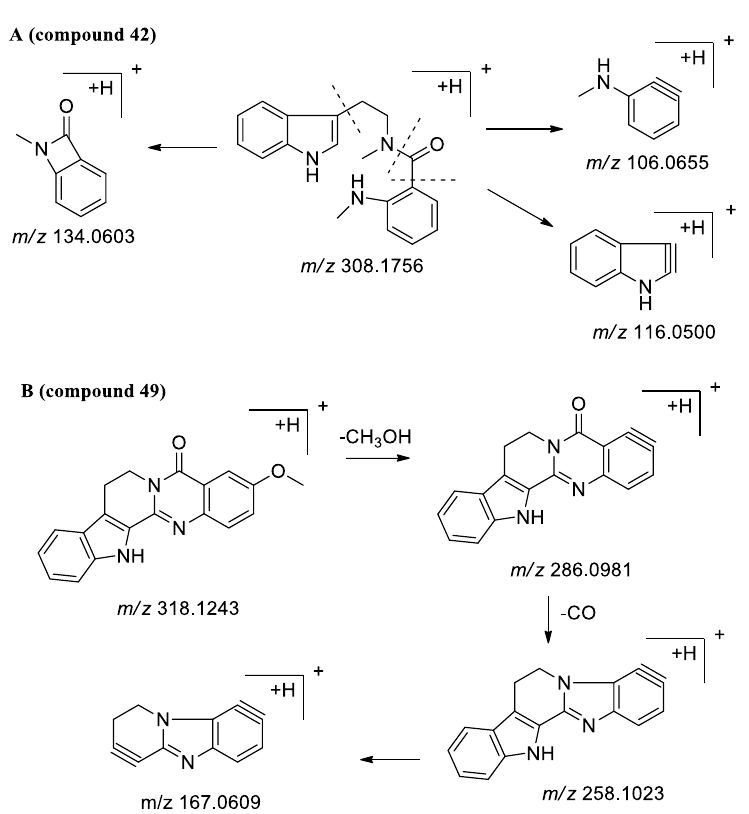
Figure 4. MS/MS proposed fragmentation pathways of evodiamide ( A ) and hortiacine ( B ).